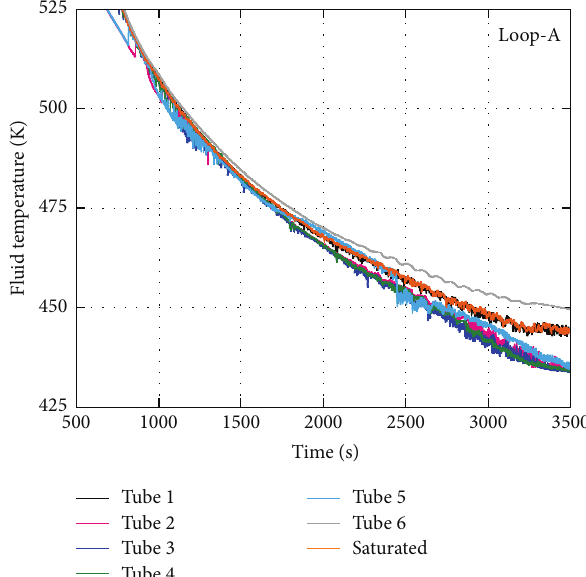
Figure 16: Measured fluid temperatures near top of SG U-tubes in loop-A in case of release of dissolved